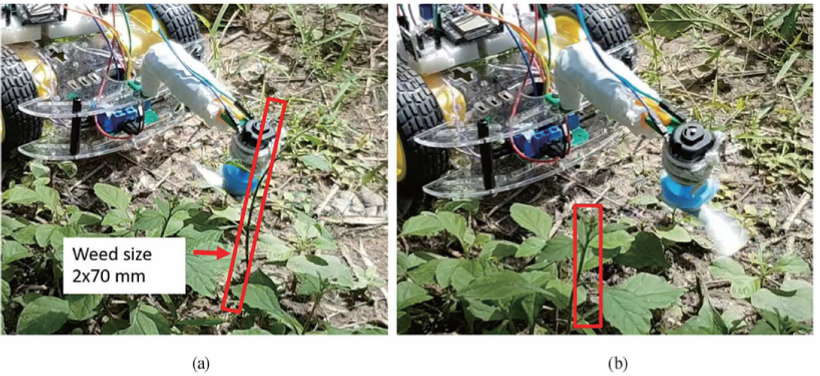
Figure 17. (Color online) Weeds ( a ) before cutting with a cutter blade and ( b ) after cutting with a cutter blade